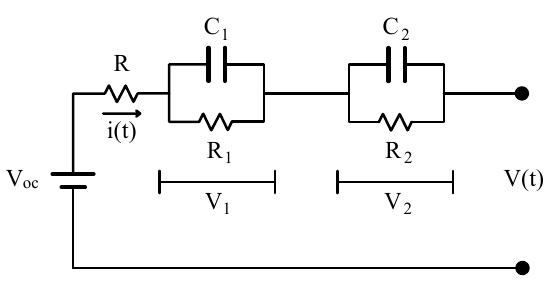
Figure 8. Thevenin battery model (2RC